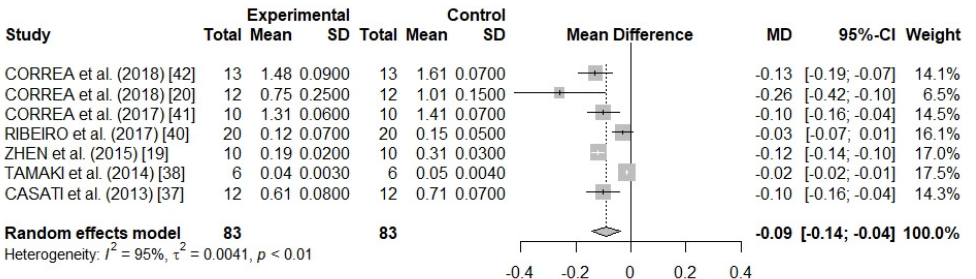
Figure 2. A forest plot of the meta-analysis for seven preclinical studies evaluating alveolar bone loss (cementoenamel junction distance to the bone crest) in methylene blue stain rat samples.